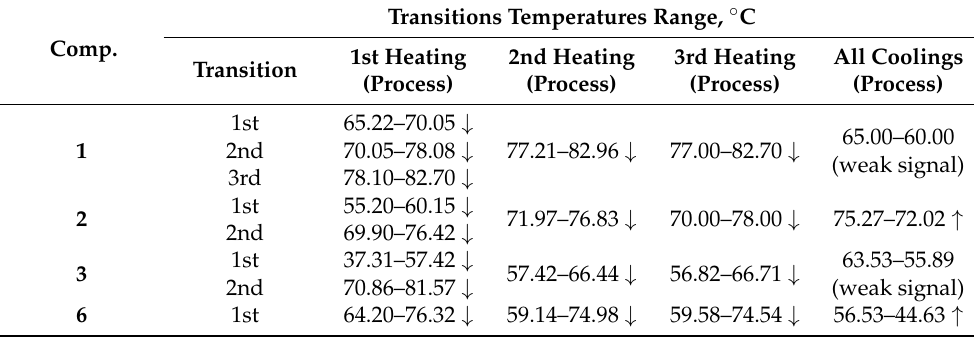
Table 1. Values obtained from DSC curves. “ ↓ “ denotes endothermic and “ ↑ “ denotes exothermic transition. Compounds 5 and 7 did not show any transitions before the decomposition temperature. Cooling curves are presented in the Supplementary data (Figure